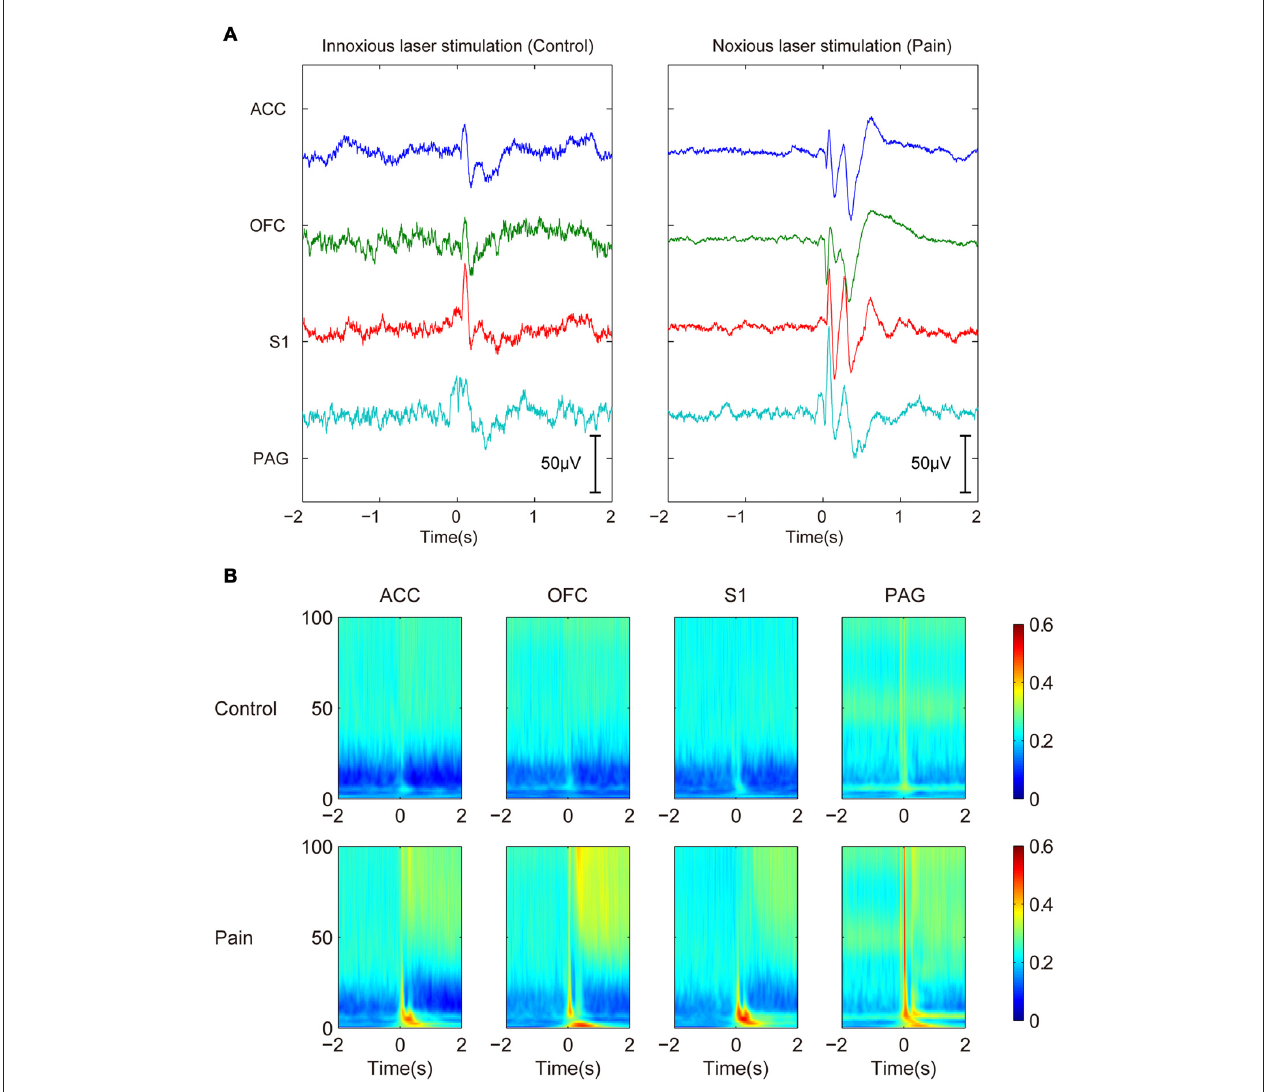
FIGURE 1 | Trial-averaged local field potentials (LFPs) show persistent power changes in γ band and inhibition in β band after noxious stimulation. (A) Trial-averaged raw field potentials. Left panel shows LEPs of control innoxious laser stimulation. Right panel shows LEP of noxious stimulation. LEP lasts about 500 ms. (B) Gabor transform of LFPs. Control group is shown in the upper panel, and Pain group is shown in the bottom panel. Persistent power changes are observed in γ band and inhibition in β band after noxious